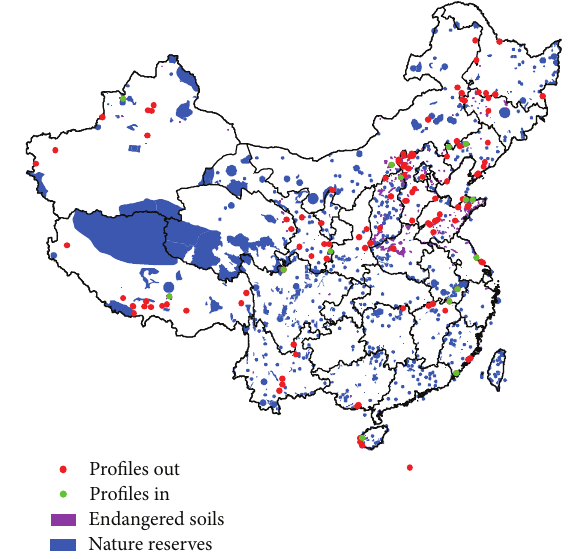
Figure 7: Endangered soils and nature reserves. The symbol